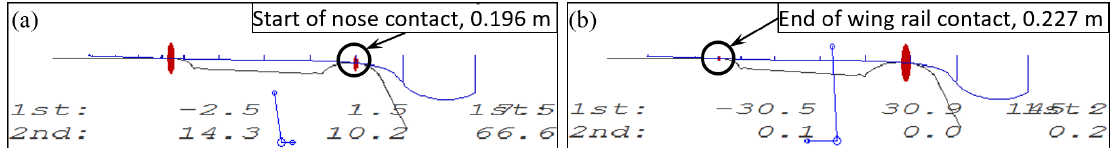
Figure 11. Transition region calculation in the MBS model: ( a ) start contact with the nose rail and ( b ) end contact with the wing rail.